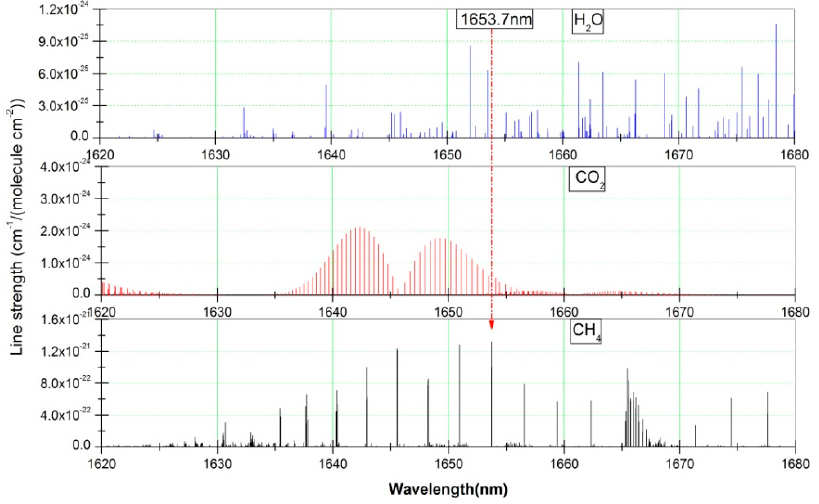
Figure 6. Absorption spectrum of the gases (H 2 O, CO 2 and CH 4 ) obtained from the HITRAN